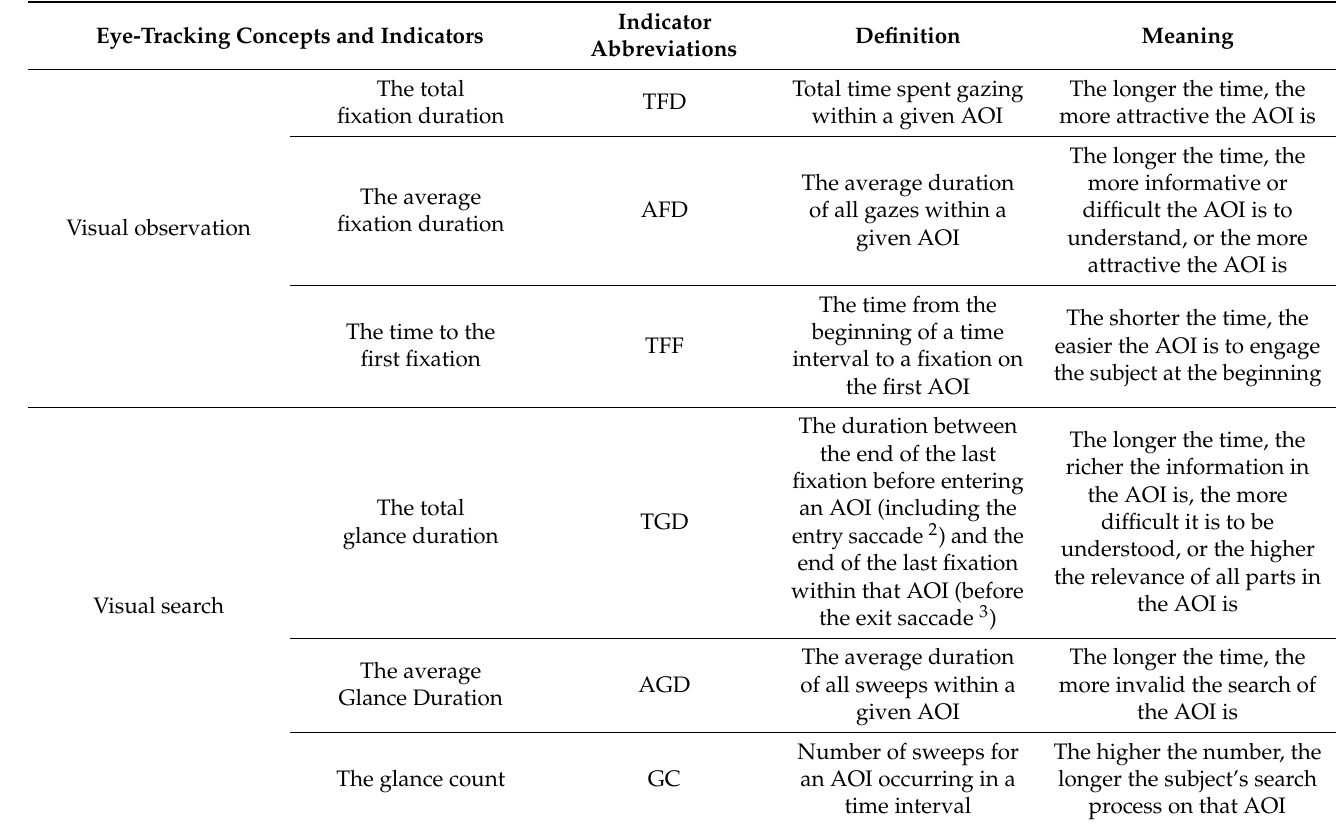
Table 1. Eye-tracking indicators and meanings 1